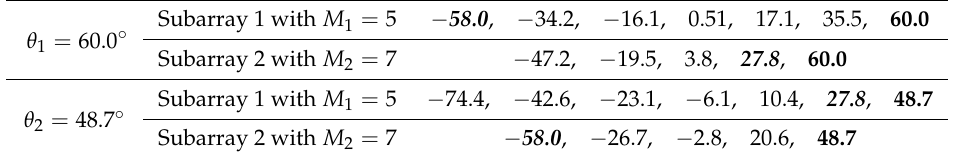
Table 1. Two directions of arrival (DOAs) and their corresponding ambiguous DOAs in each subarray.